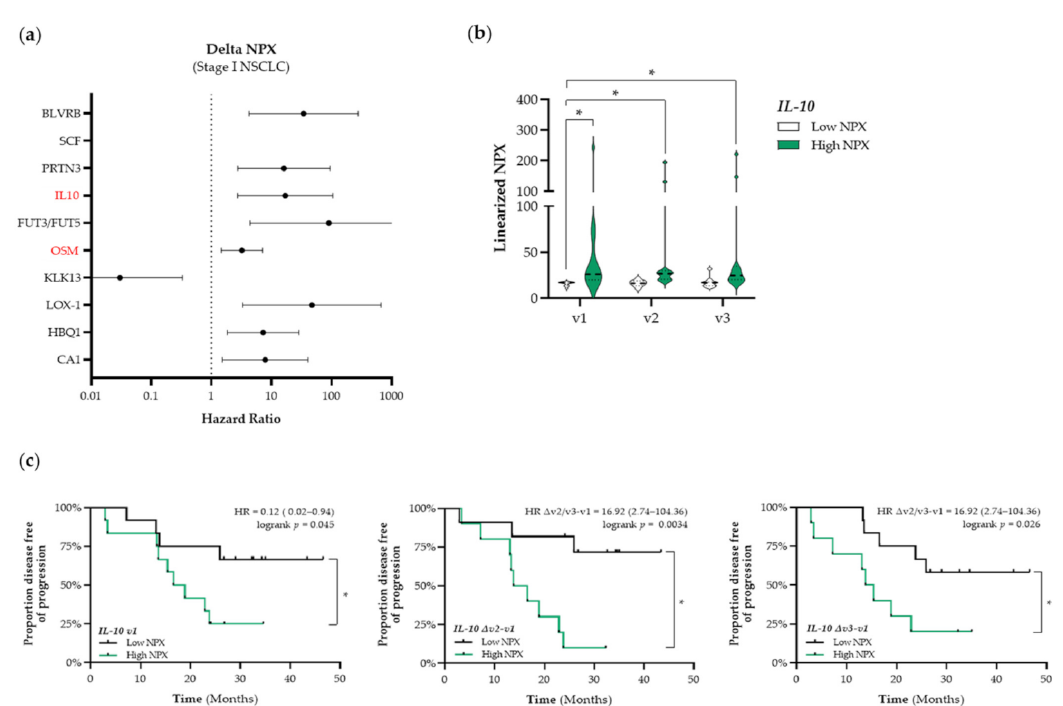
Figure 5. Identification of predictive immune-related proteins that are altered in response to therapy in patients with stage I NSCLC. ( a ) The Cox Proportional-Hazards model was used to identify proteins of which the delta NPX value was associated with PFS in patients with stage I NSCLC ( n = 25). The top 10 proteins of which the delta NPX value was associated with PFS in patients with stage I are displayed in a forest plot. The closed circles represent the Hazard Ratio of each identified protein and the horizontal lines illustrate the 95% confidence interval. Immune-related proteins are indicated in red. ( b , c ) Patients with stage I NSCLC ( n = 25) were stratified into low (black) or high (green) IL-10 (interleukin-10) NPX-based “risk groups” by considering the median NPX value of the IL-10 protein at v1 as a cut-off. ( b ) The linearized IL-10 NPX values are presented in a violin plot, showing the distribution of the IL-10 NPX values at each timepoint. The median is indicated by the dashed line, the quartiles are indicated by the dotted lines. ( c ) Kaplan–Meier plots of the low IL-10 NPX group and high IL-10 NPX group on the patient’s PFS at baseline (v1) ( left ) , after the 2nd fraction of SBRT ( ∆ v2 − v1) ( middle ), and after the final fraction of SBRT ( ∆ v3 − v1) ( right ). A nominal p -value less than 0.05 was considered to be statistically significant and is indicated through an asterisk